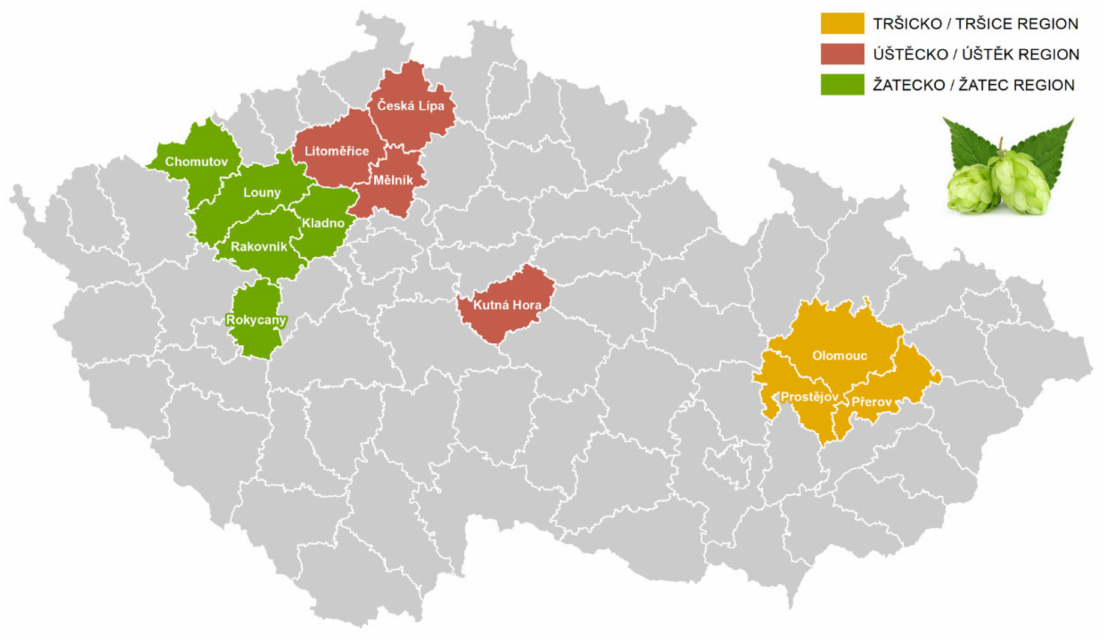
Figure 1. The map of hop-growing areas in the Czech Republic; own processing based on